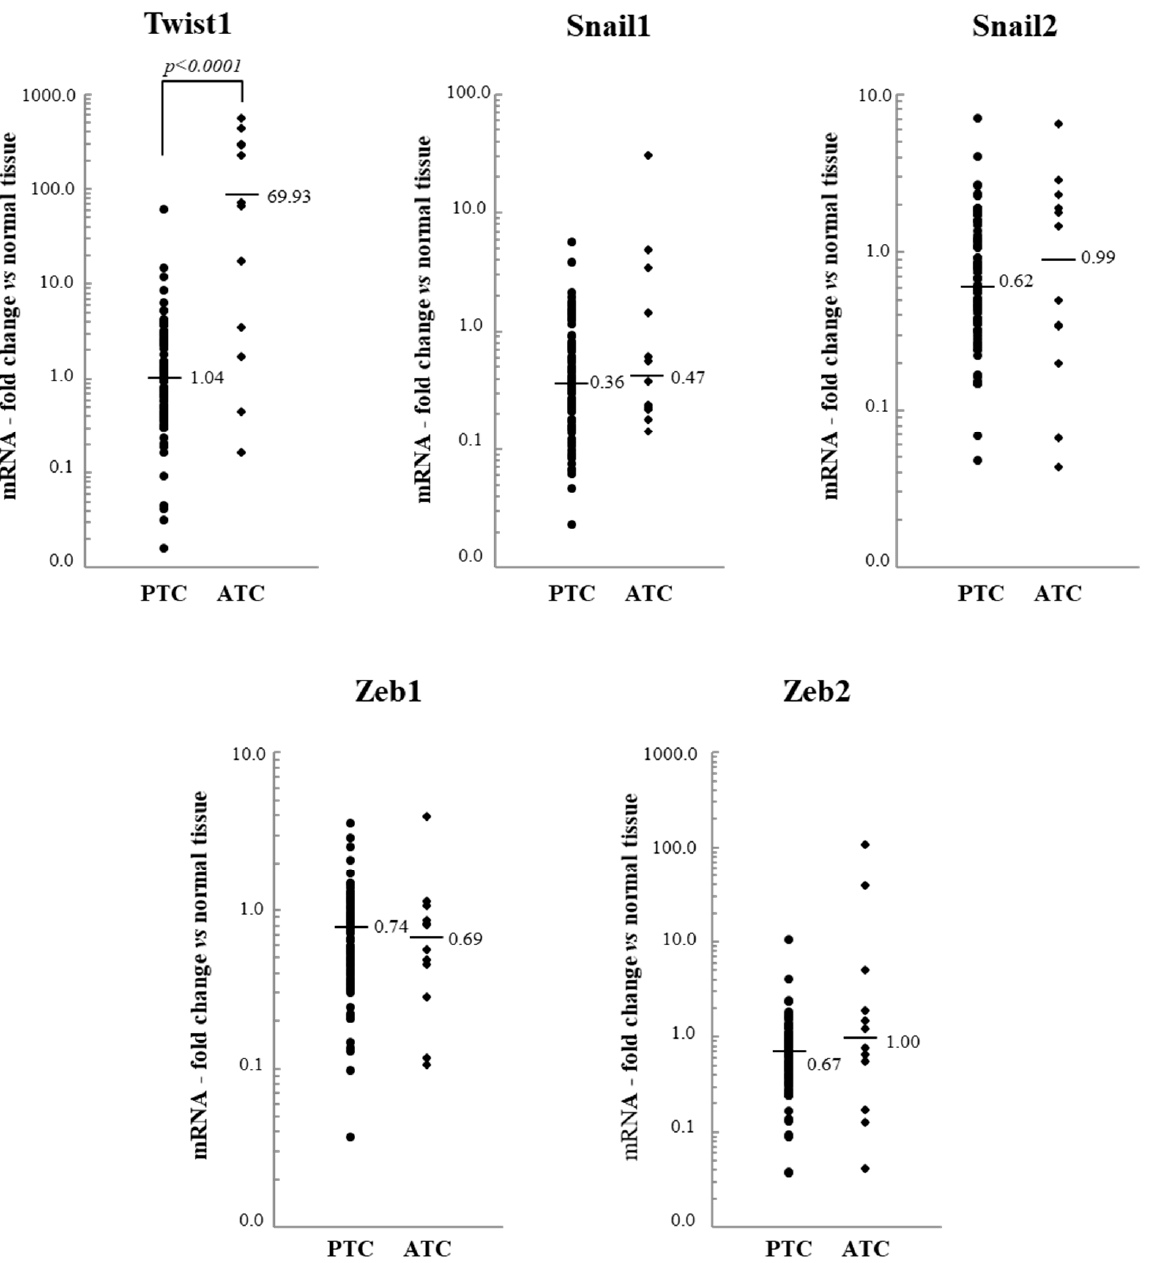
Figure 4. Expression level of the EMT transcription factors (EMT-TFs) in 95 papillary thyroid cancer (PTC) and 12 anaplastic thyroid cancer (ATC) tissues. The small bars represent the median with the values indicated. The dotted line represents the expression level in normal tissues.